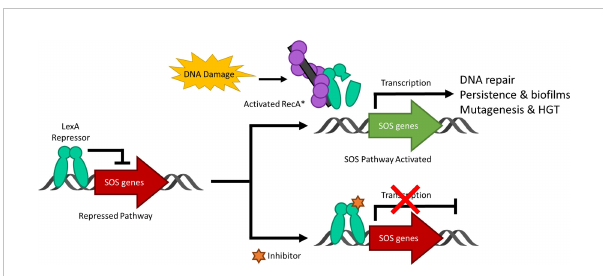
FIGURE 1 A schematic representing the bacterial SOS response to DNA damage and the inhibition of the pathway. Under standard conditions, the LexA dimer is bound to the promotor region repressing the transcription of the SOS response genes. Upon DNA damage and the activation of RecA to form nucleoprotein RecA* fi laments, LexA undergoes proteolysis and derepresses the SOS genes as it is no longer able to bind to the promoter region. When a small molecule inhibitor is bound to LexA, the antibiotic-evasion associated pathway is antagonized and the SOS genes are not transcribed. Note that HGT stands for horizontal gene